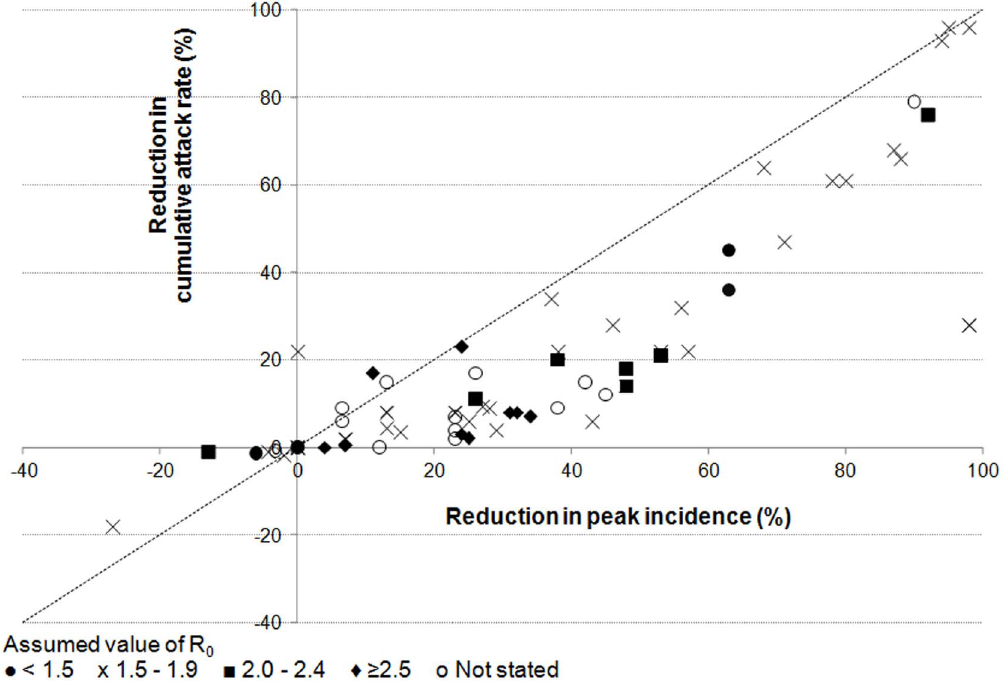
Figure 3. Plot of the predicted reduction in the cumulative attack rate against that in the peak incidence (all ages). Each marker represents the results of one analysis. Different symbols are used to reflect different values for R 0 .